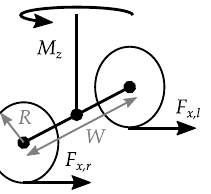
Figure 4. Yaw moment conversion scheme.